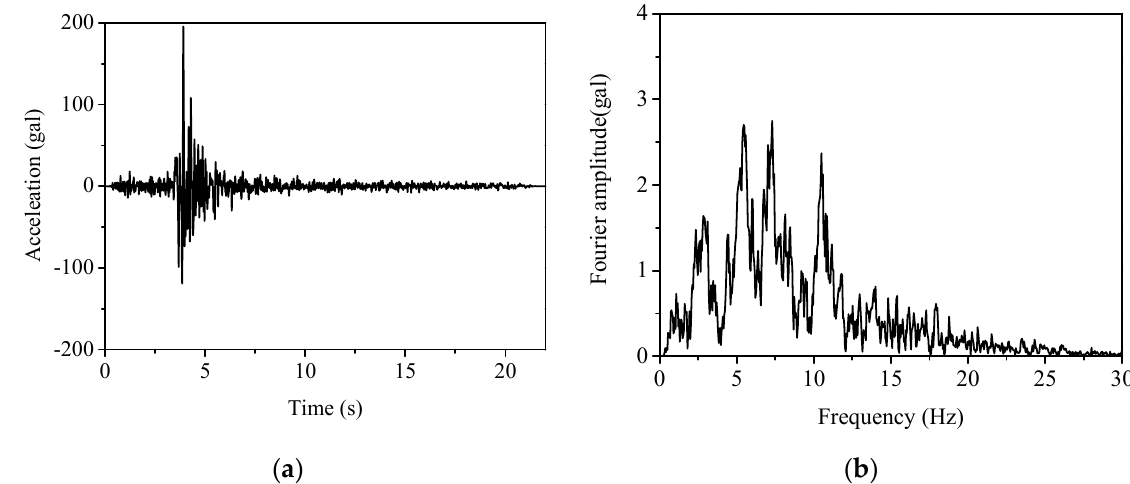
Figure 18. ( a ) Acceleration record of the Oroville–01 seismic wave and ( b ) its Fourier spectra.